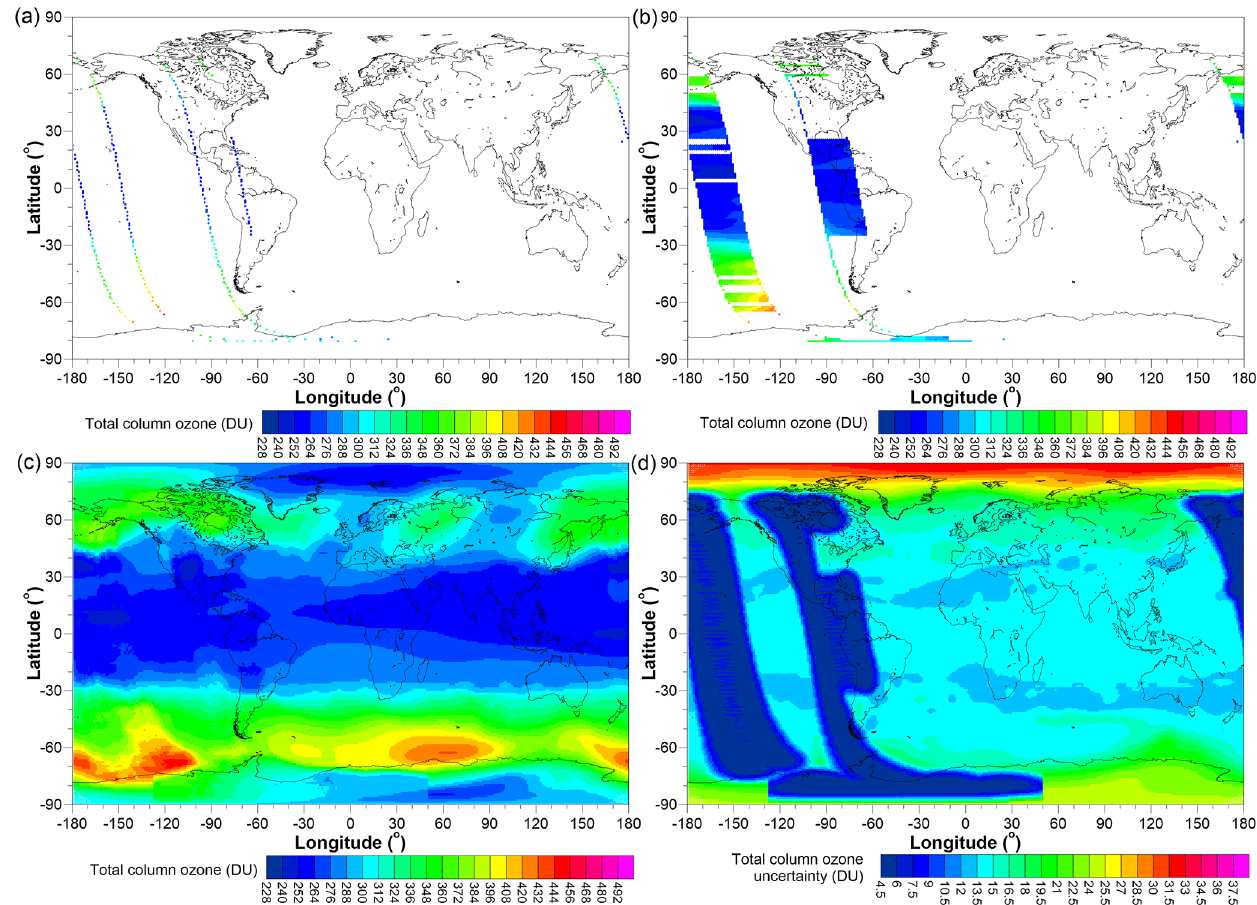
Figure 15. (a) The original unfilled TCO field on 31 October 1978, (b) the conservatively filled field, (c) the final filled field, and (d) the uncertainties on the final filled